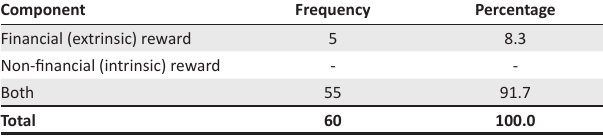
TABLE 1: Type of reward management systems at Ghana Commercial